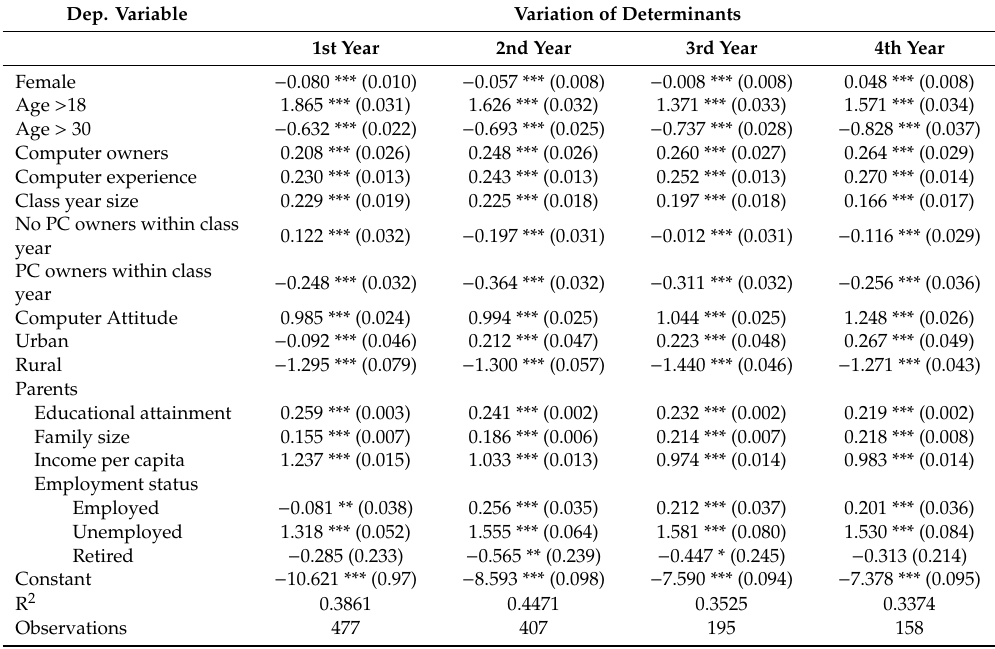
Table 7. Internet access logistic regression estimates for EA undergraduate